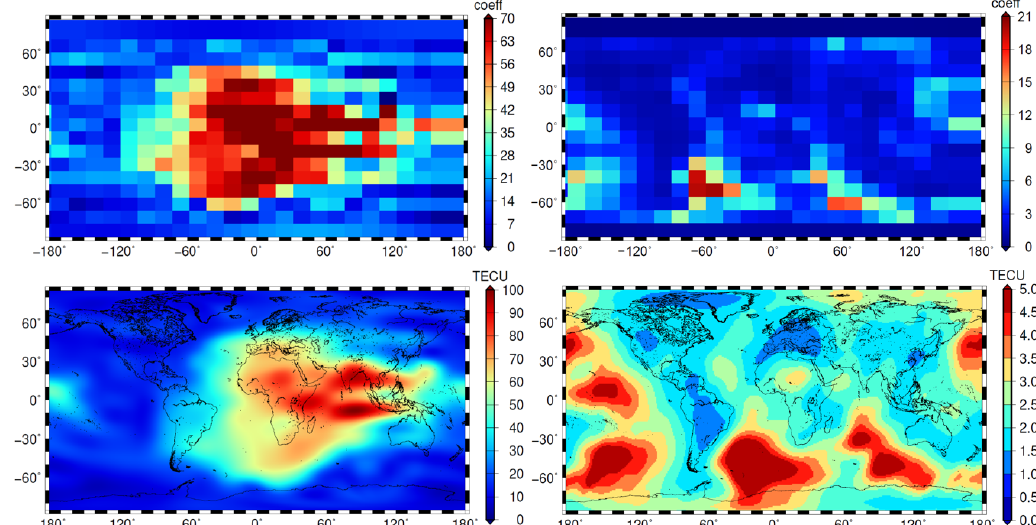
Figure 5. Estimated coefficients ( top left ) and their standard deviations ( top right ) for the level values J 1 = 4 and J 2 = 3 within the GSM coordinate system; estimated vertical total electron content (VTEC) values ( bottom left ) and their standard deviations ( bottom right ) as GIMs defined in the geographical coordinate system; all sets calculated for 17 March 2015 at 12:00 UT.